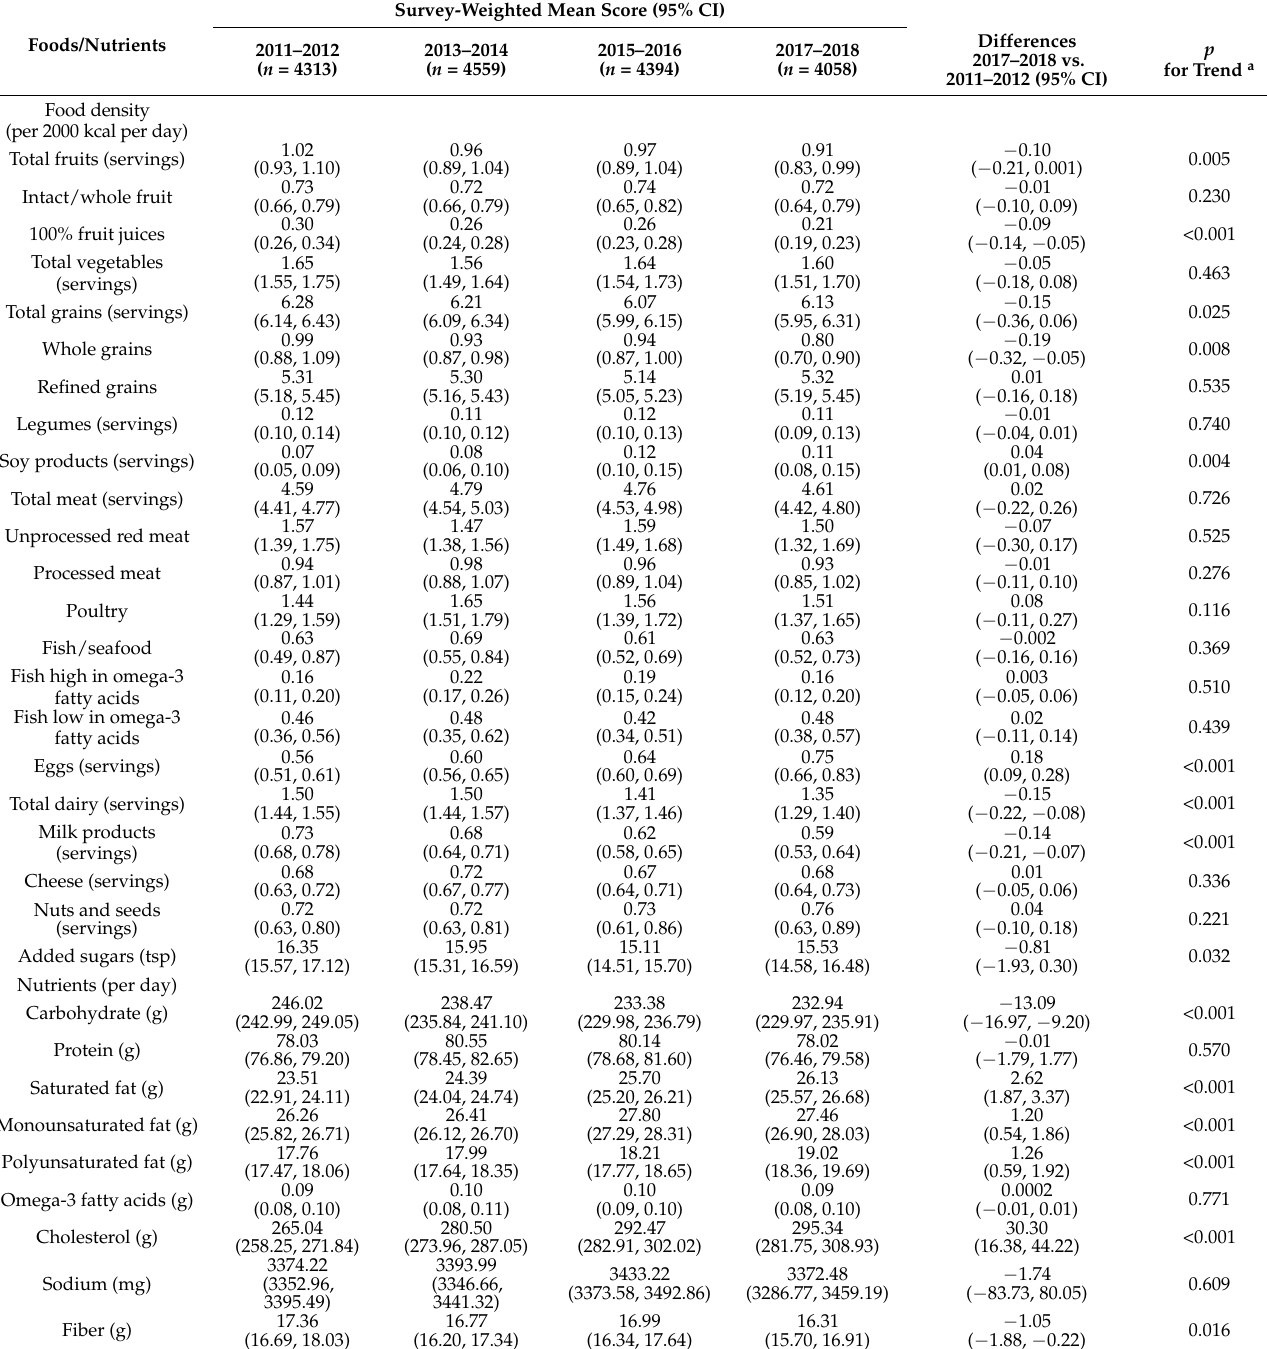
Table 2. Trends in estimated mean consumption of food groups and nutrients among adults aged ≥ 20 years, NHANES